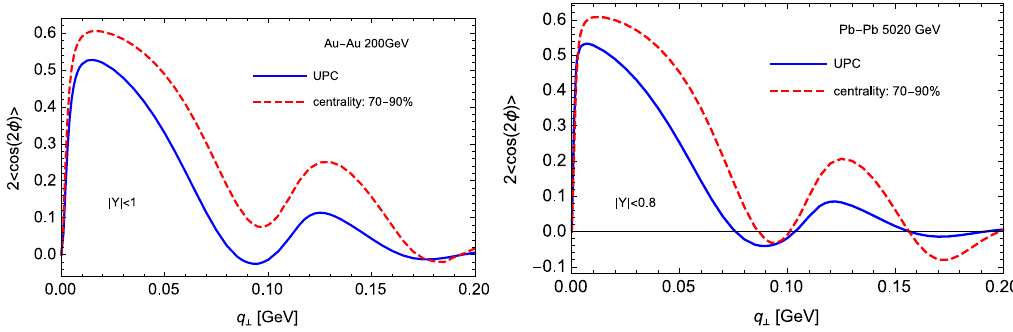
Figure 4 . (color online) The cos 2 (cid:30) azimuthal asymmetries in (cid:26) 0 production(Xn-Xn events) in heavy ion collisions at RHIC and LHC energies. The computed cos 2 (cid:30) in UPC at RHIC energy(left panel, solid line) can qualitatively describe the preliminary measurement by the STAR collabo- ration [29]. The asymmetry in peripheral collisions with centrality region from 70%-90% is also presented with the dashed